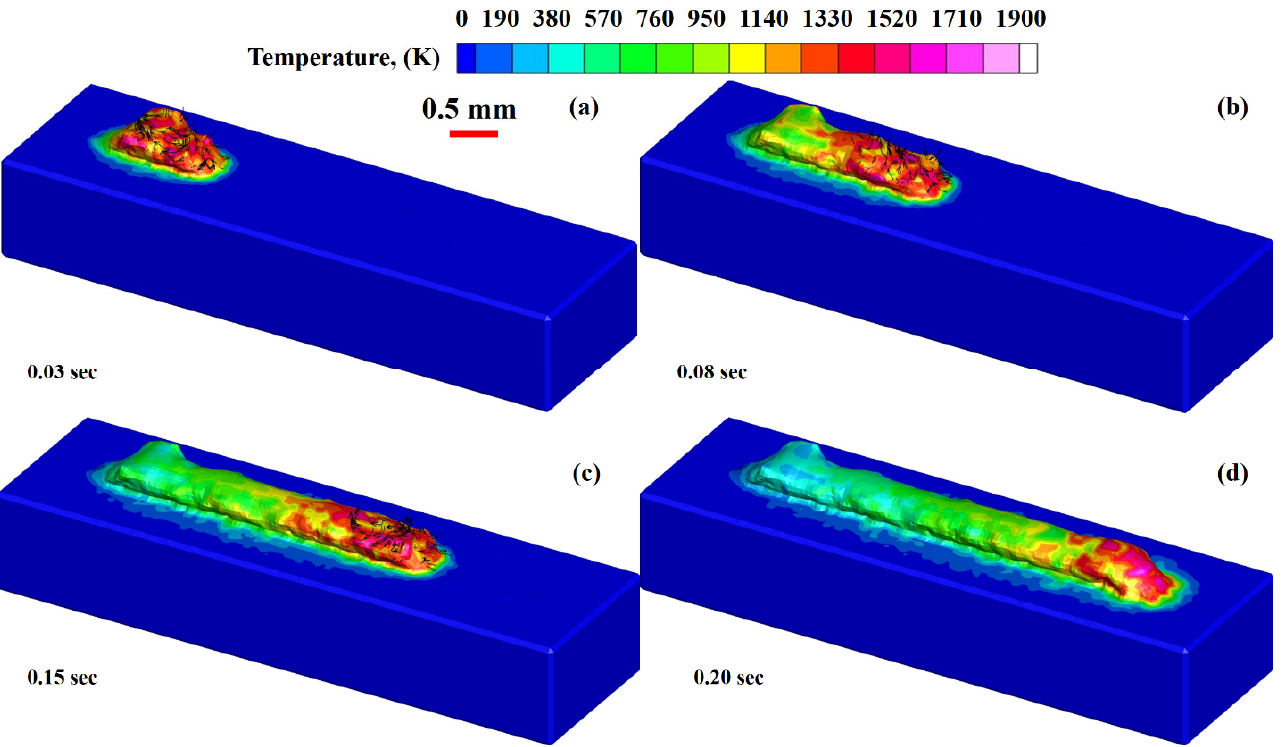
Figure 5. Temperature distribution of the printed layer at various intervals: ( a ) 0.03 s, ( b ) 0.08 s, ( c ) 0.15 s and ( d ) 0.20 s.